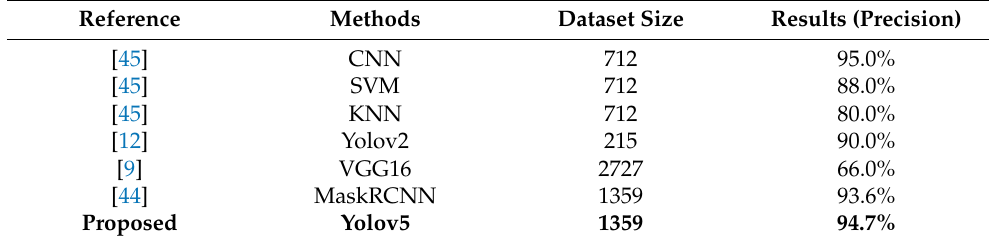
Table 1. Comparison between the precision achieved by the proposed approach and other competing